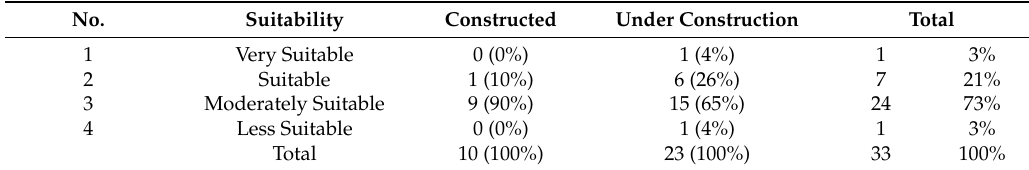
Table 8. Overall location